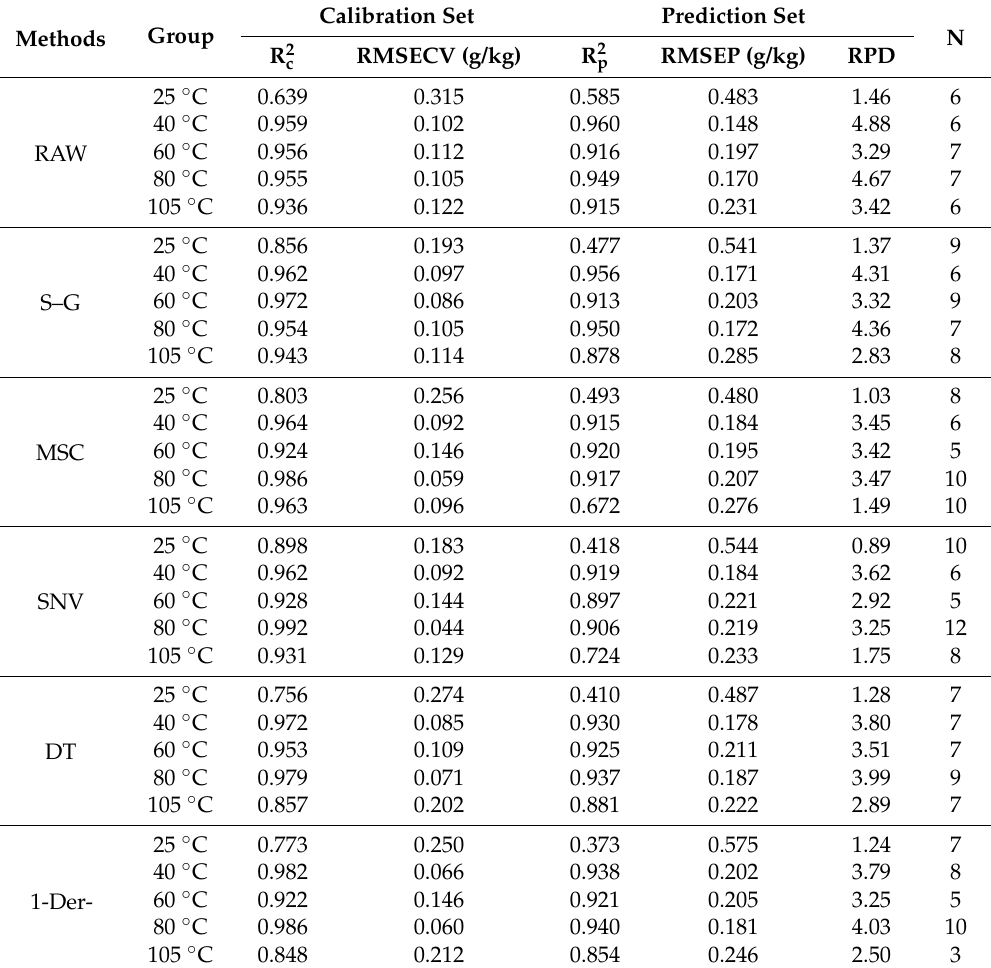
Table 1. The prediction effects with different spectral pretreatments and different drying temperatures by the partial least squares